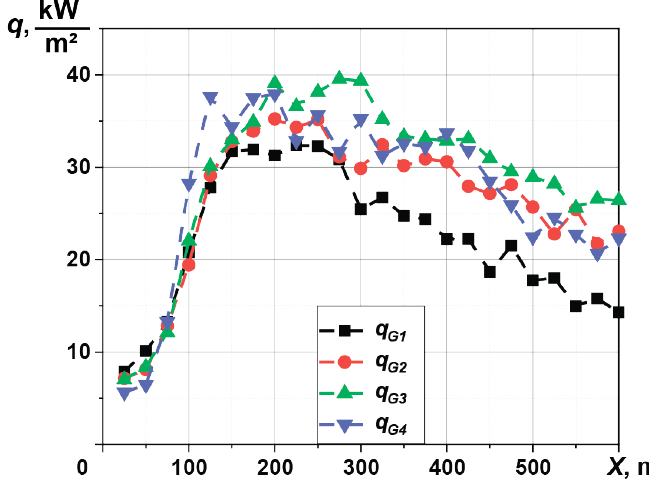
Figure 14. Dependence of the local heat flux on the longitudinal coordinate at various fuel mass flow rates: q G 1 = 6.5 kg/h, q G 2 = 7.1 kg/h, q G 3 = 7.95 kg/h, q G 4 = 8.6 kg/h.